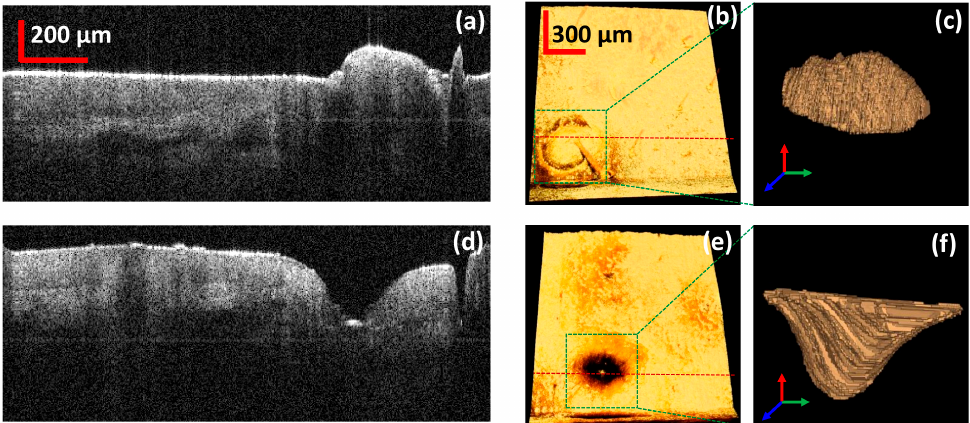
Figure 4. Comparative analysis of the high lateral resolution OCT images before and after the sebum extraction. ( a , d ) Cross-sectional OCT images of the sebum region are indicated by the red dotted line in ( b , e ); ( b , e ) 3D enface images; ( c , f ) enlarged volumetric ROI indicated by the blue dotted square in ( b , e